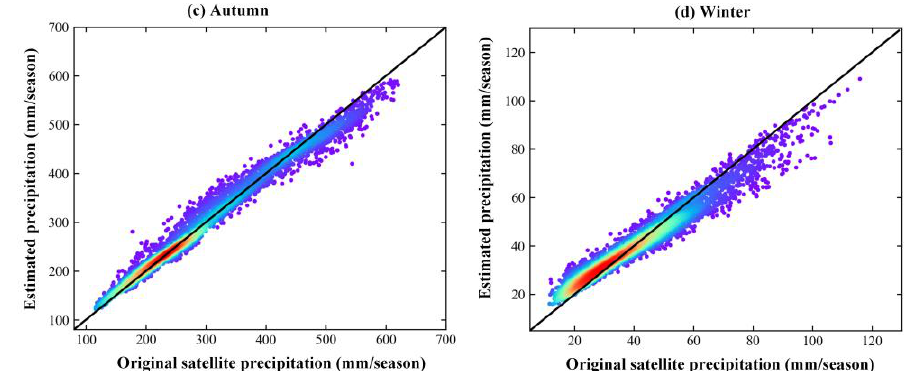
Figure 4. Scatter plots (the color bar represented the density of the point distribution) of the original